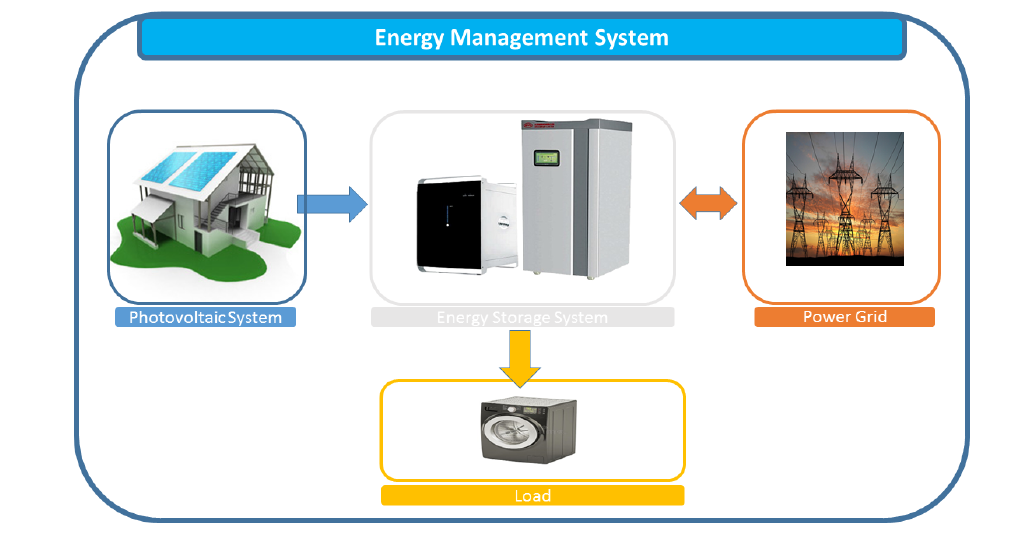
Figure 1. A sample system consisting of photovoltaics (PV), an energy-storage system (ESS), power grid, and household load, which is managed by an